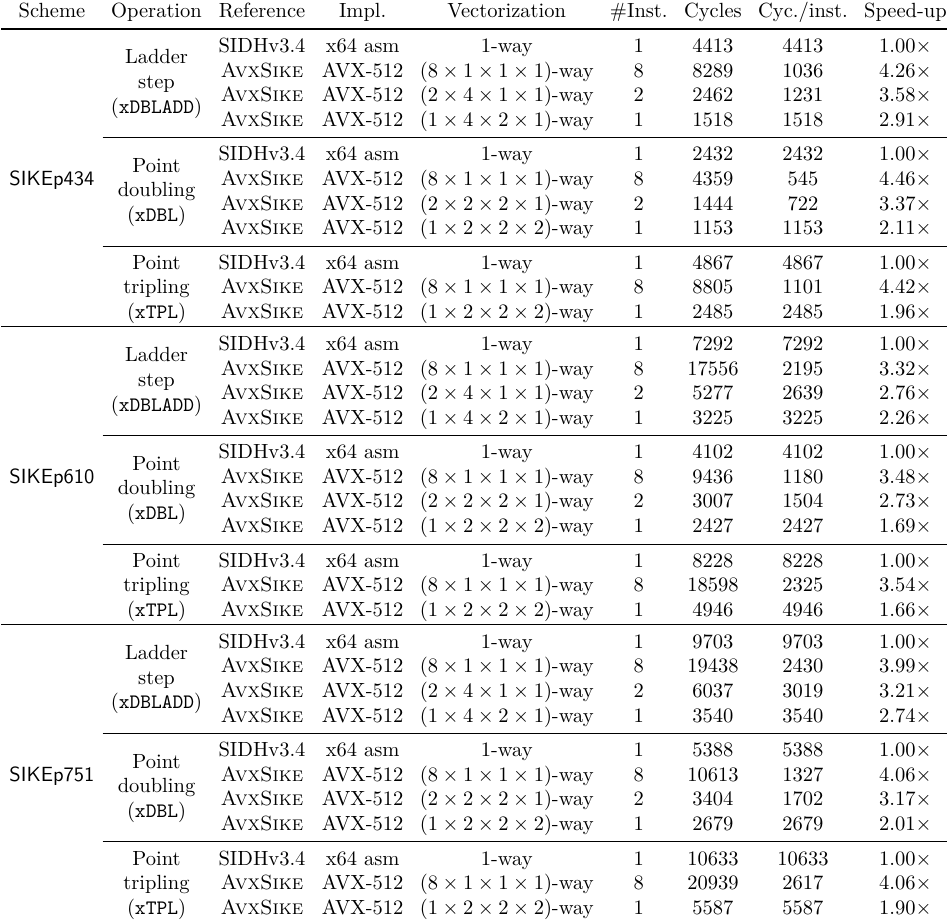
Table 9: Benchmarking results of implementations of point operations.